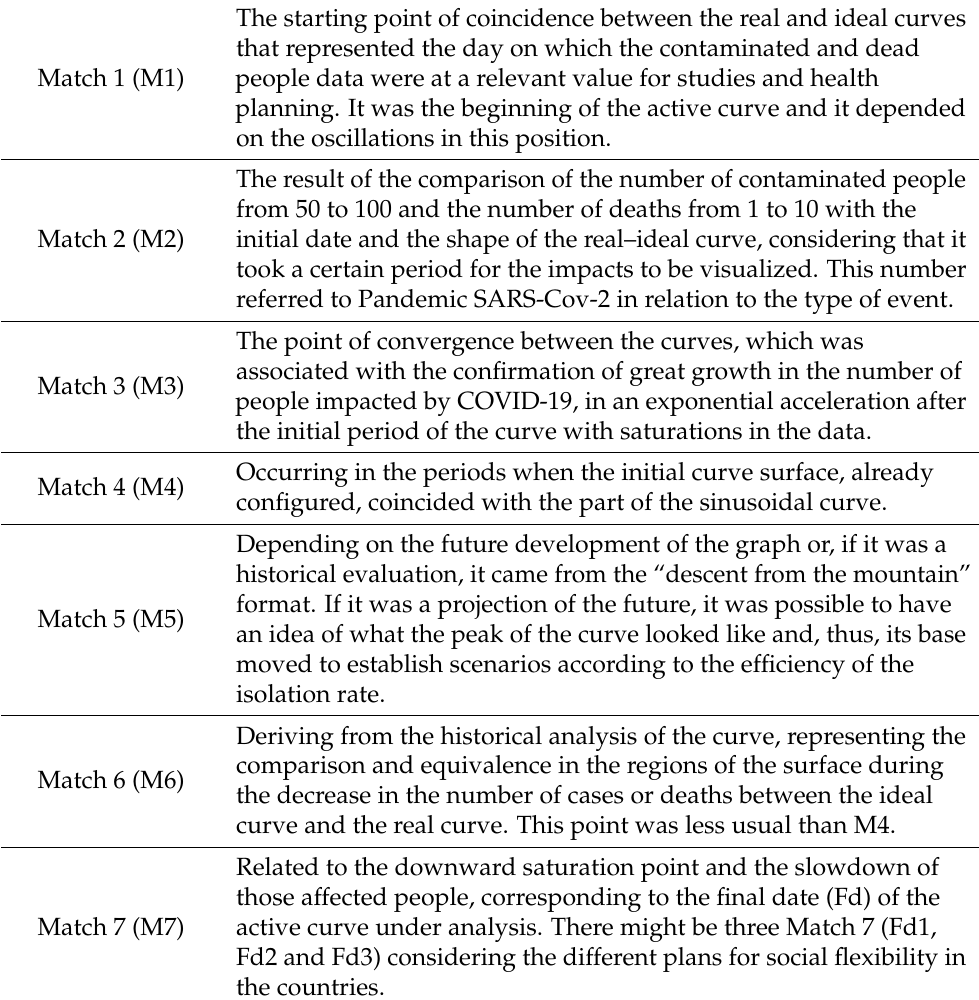
Table 1. Matches and respective